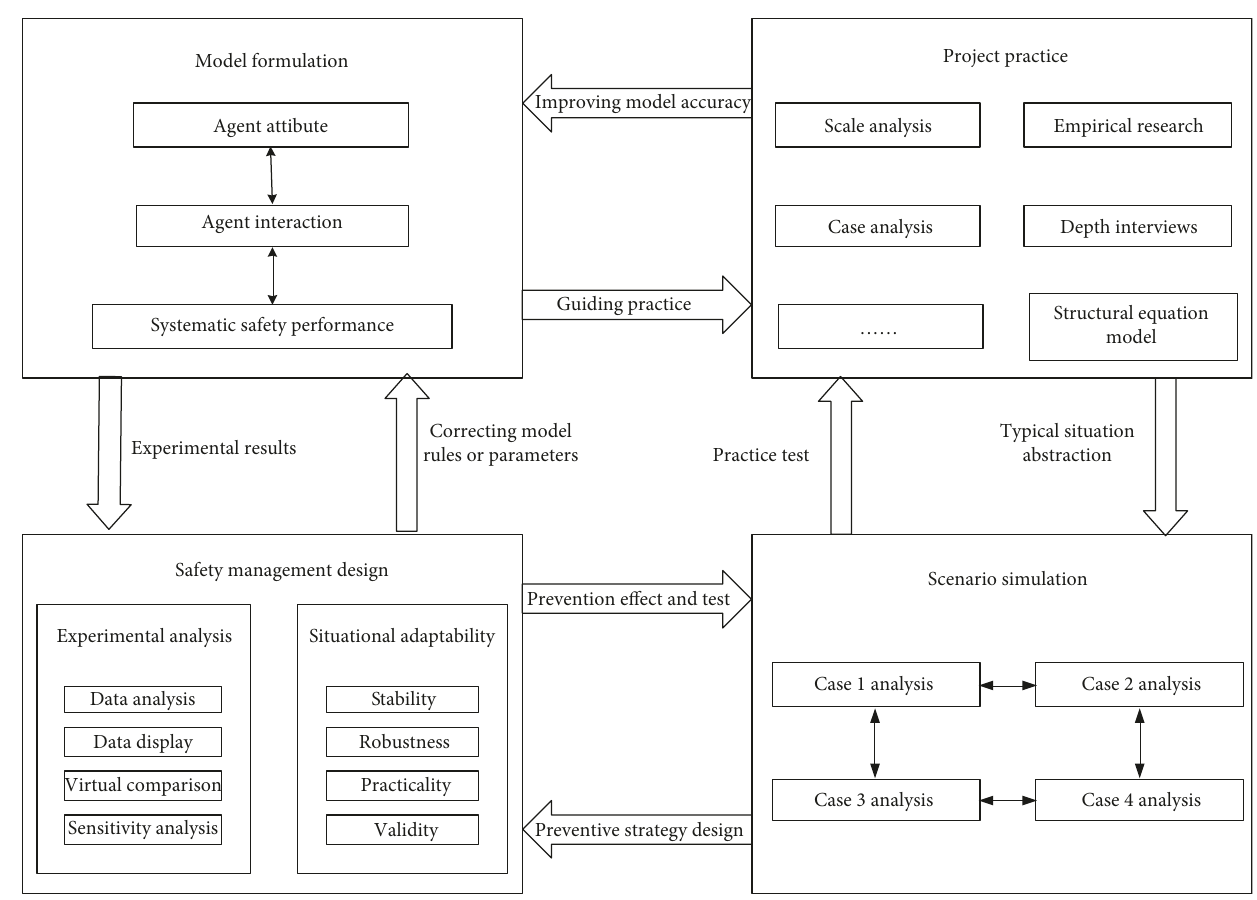
Figure 1: Research ideas and design of strategies for prevention of unsafe behavior in construction